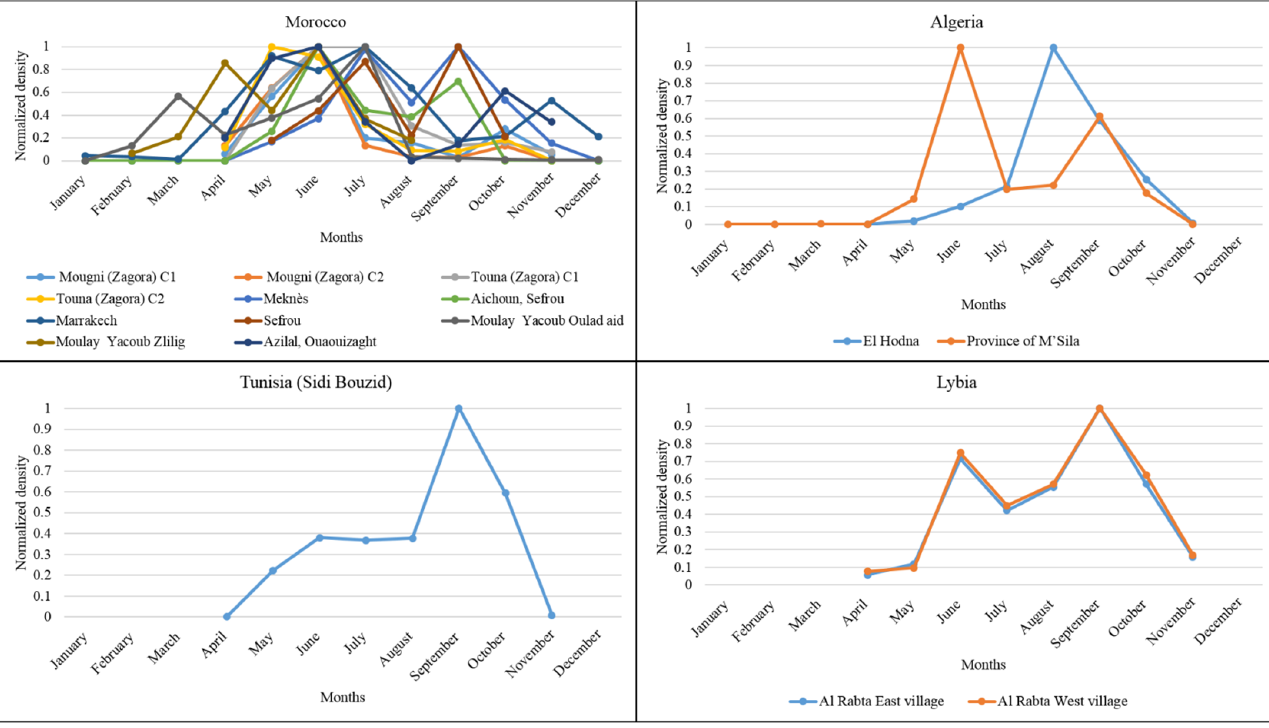
Figure 4. The normalized monthly density of the P. papatasi with 0 indicates no data/absence of activity, and 1 shows high density in the studied sites in the Northern African countries. Our analysis at the North African geographic scale depicts a seasonal activity of P.